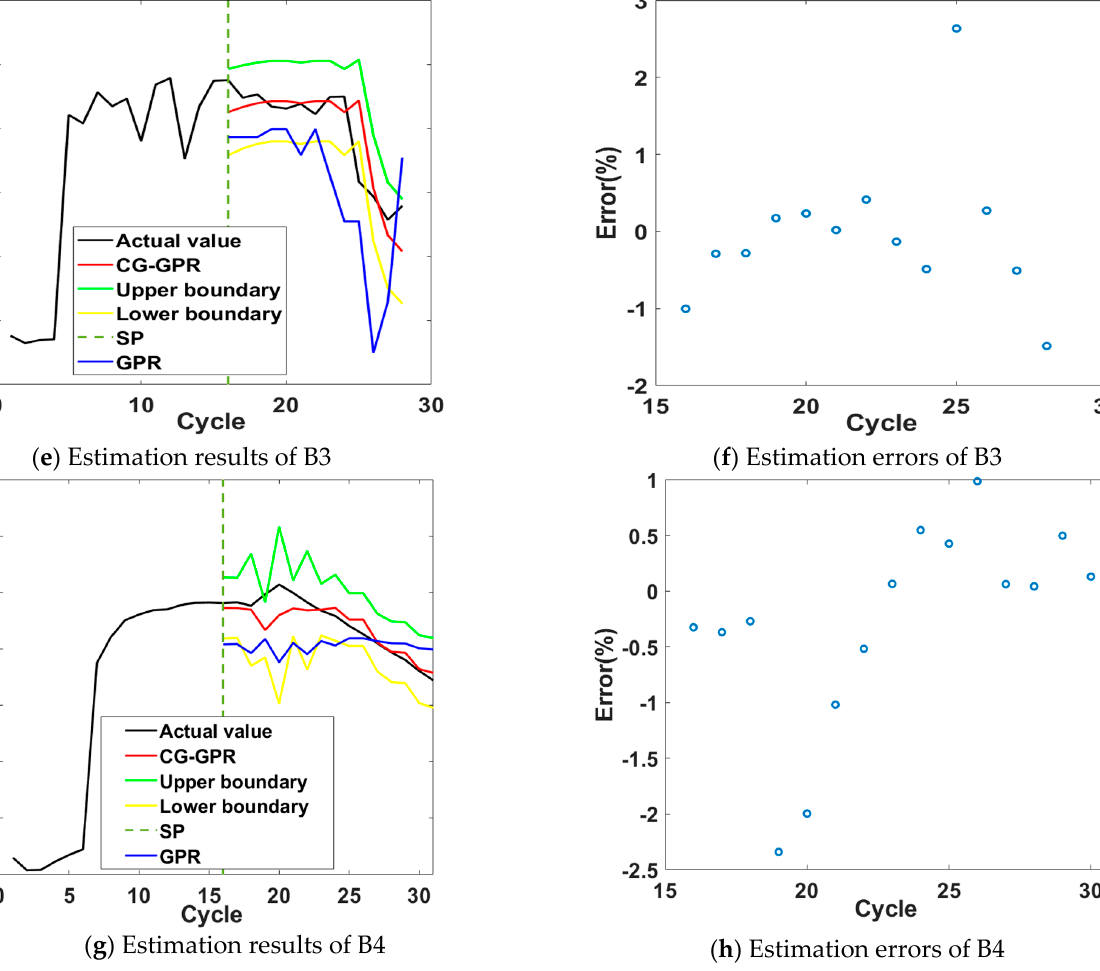
Figure 7. The estimation results of capacity degradation trajectory and relatively error for each battery.